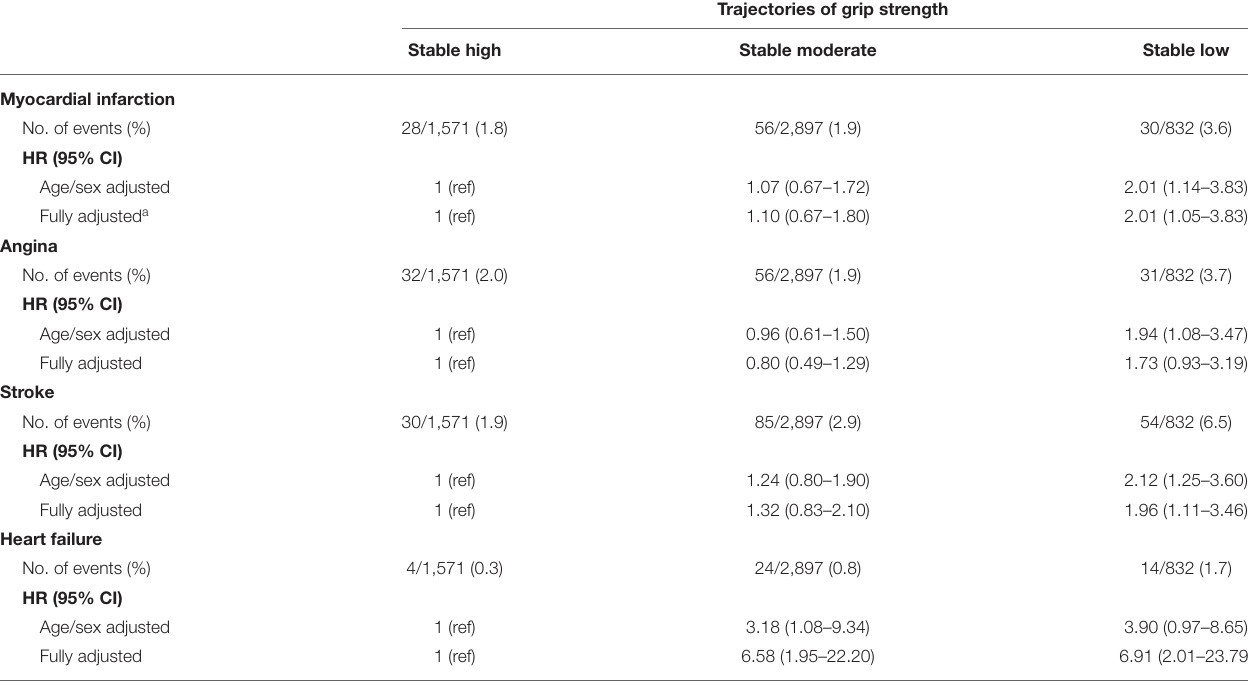
TABLE 3 | Cox regression analyses for the components of the CVD events per trajectory of grip strength